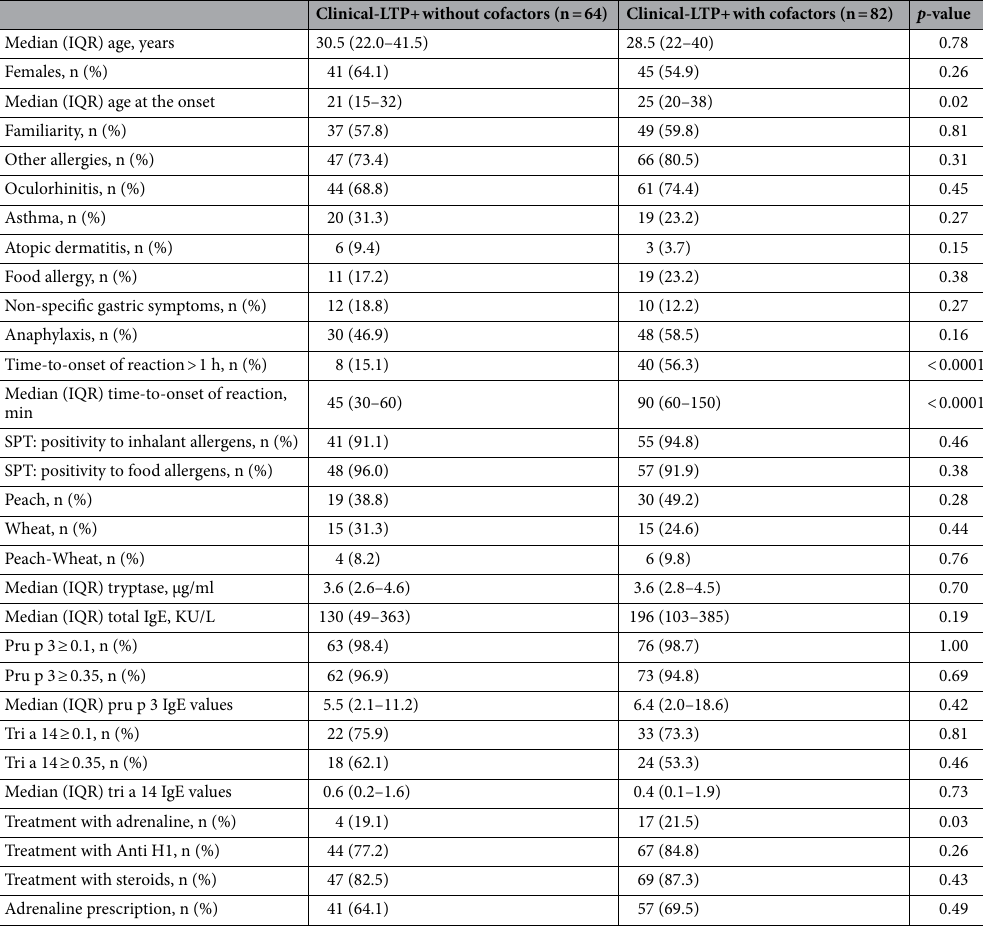
Table 7. Comparison between clinical-LTP + without and with